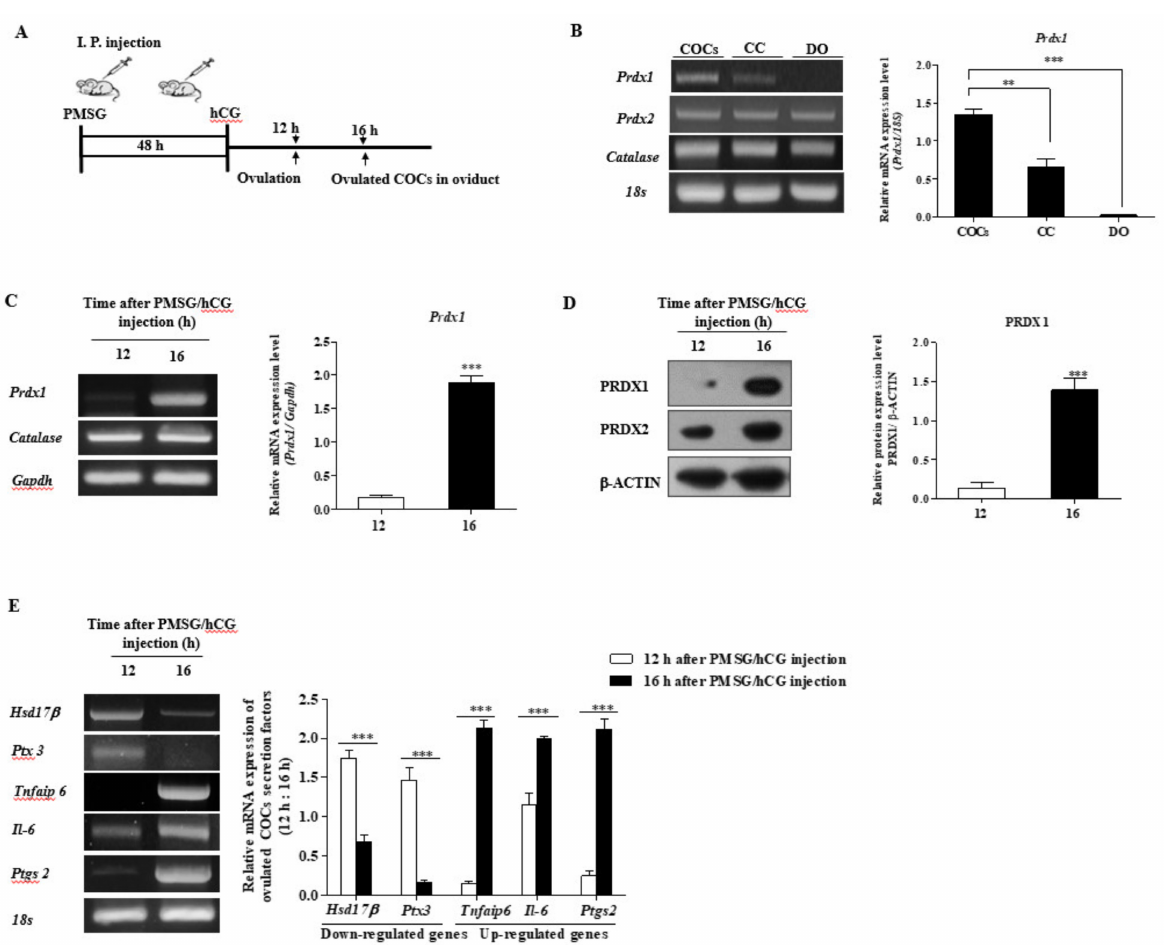
Figure 1. Changes in the Prdx1 gene and secretion factor expression patterns from ovulated cumulus–oocyte complexes (COCs) at 12 and 16 h after pregnant mare serum gonadotropin (PMSG)/hCG injection. ( A ) Schematic diagram of hormone- induced superovulation in mice: 12 or 16 h after PMSG-hCG injection, ovulated COCs were obtained from the oviducts. ( B ) Expression levels of antioxidant enzymes ( Prdx1, 2, and Catalase ) in COCs, CC, and DOs were measured by RT-PCR analysis. ( C ) The mRNA levels of Prdx1 and catalase as antioxidant enzymes in isolated COCs were measured by RT-PCR analysis. The mRNA levels of these genes were normalized to the Gapdh expression level as a control. ( D ) Protein expression levels of PRDX1 and PRDX2 in isolated COCs were measured by Western blot analysis. The levels of PRDX 1 and 2 were normalized to β -ACTIN expression level as a control. ( E ) The mRNA expression levels of ovulated COC-secreted factors (downregulated genes: Hsd17 β and Ptx3 ; upregulated genes: Tnfaip6, Il-6, and Ptgs2 ) in isolated COCs were measured by RT-PCR analysis. The mRNA levels of these genes were normalized to the 18S expression level as a control. The histogram represents the values of the densitometry analysis that were obtained using Image J software. The data are representative of at least three independent experiments conducted in triplicate and shown as means ± SEM (30 COCs per group). **, p < 0.01; ***, p < 0.001 for analyses of these data via t -tests compared with 12 h after PMSG/hCG injection, and via Dunnett’s multiple comparison test compared with the COC